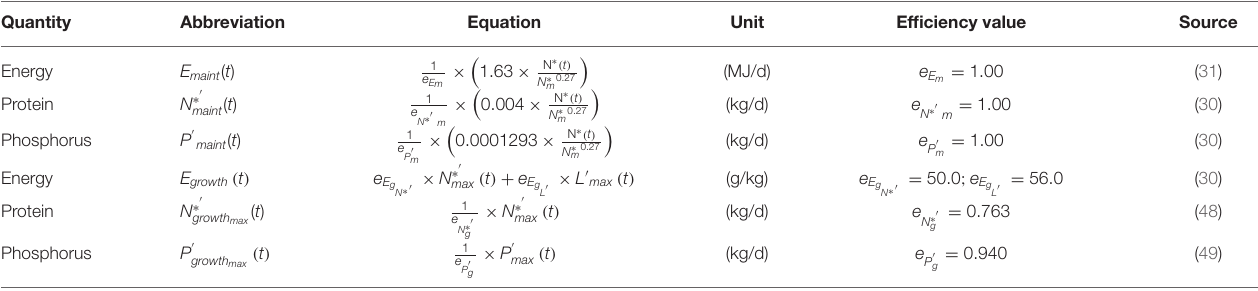
TABLE 1 | Equations to estimate individual daily requirements for maintenance and growth in terms of effective energy ( E ), digestible protein ( N ∗ ) and digestible phosphorus (P).